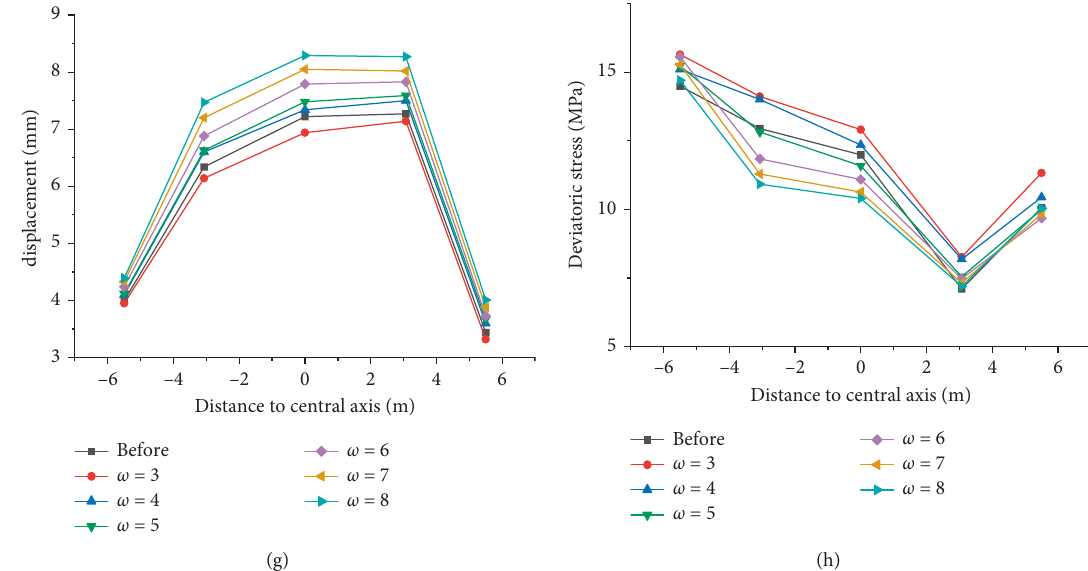
Figure 16: Simulation results of key points of surrounding rocks at the 0 inclination angle. (a) Displacement of the respective key point at an inclination angle of 0. (b) Deviatoric stress of the respective key point at an inclination angle of 0. (c) Displacement of the respective key point at an inclination angle of 30. (d) Deviatoric stress of the respective key point at an inclination angle of 30. (e) Displacement of the respective key point at an inclination angle of 45. (f) Deviatoric stress of the respective key point at an inclination angle of 45. (g) Displacement of the respective key point when the inclination is 60. (h) Eccentric stress of the respective key point when the inclination is